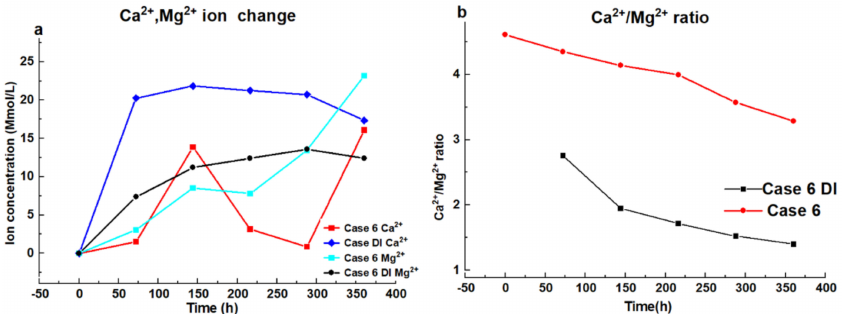
Figure 6. The increase in Ca 2+ and Mg 2+ concentrations for Case 6 and Case 6 DI ( a ). Change of Ca 2+ /Mg 2+ concentration ratio for Case 6 and Case 6 DI ( b ).